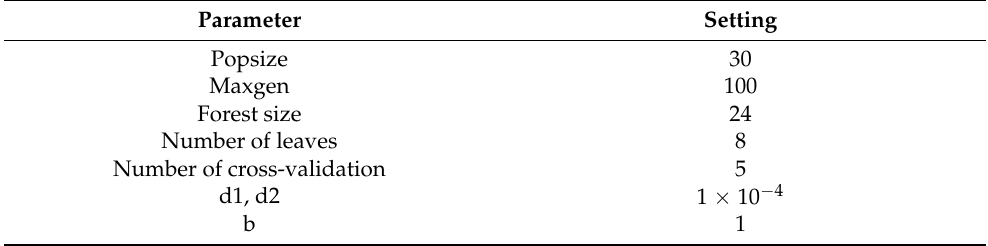
Table 4. Parameter settings for the MWOA-RF model.